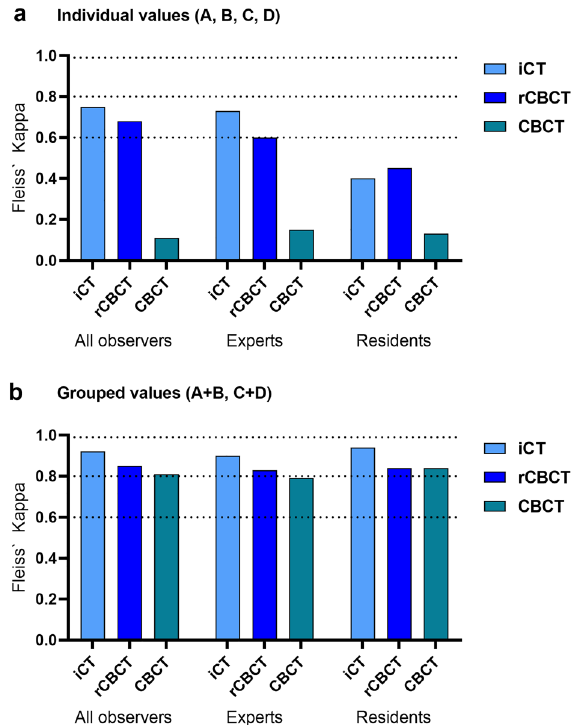
Figure 5. Interobserver reliability of screw accuracy depending on intraoperative imaging modality via Fleiss’ Kappa analysis. ( a ) shows the interobserver reliability of the individual accuracy analysis comparing modified Rampersaud A, B, C and D of All observers, Experts, and Residents depending on the intraoperative imaging modality. ( b ) shows the interobserver reliability of the accuracy analysis grouped according to non-relevant (modified Rampersaud A + B) and relevant (modified Rampersaud C + D) pedicle breaches. The dashed lines illustrate the interobserver reliability of substantial (> 0.6), almost perfect (> 0.8), and perfect (> 0.99) agreement according to the interpretation of reliability by Landis & Koch (< 0 less than chance, 0.01–0.2 slight, 0.21–0.4 fair, 0.41–0.6 moderate, 0.61–0.8 substantial, 0.81–0.99 almost perfect